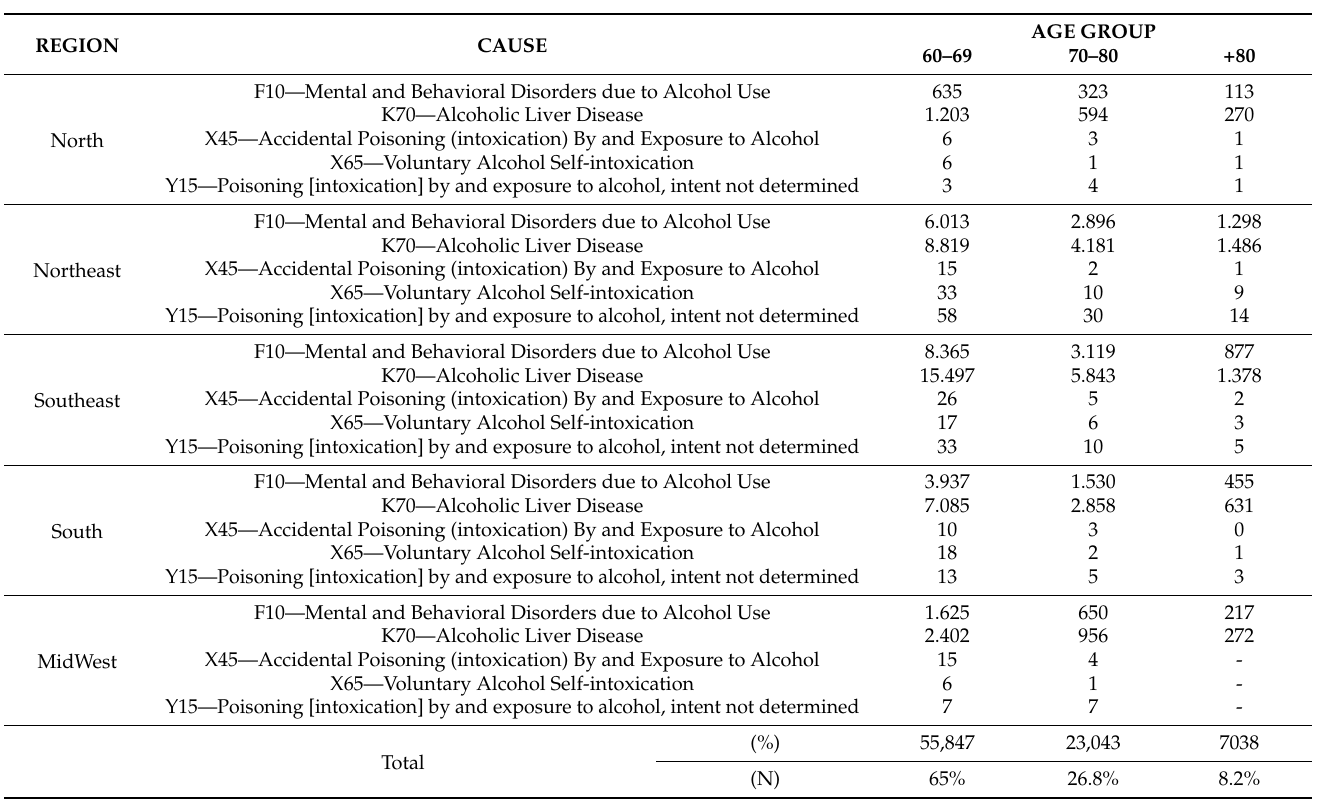
Table 2. Mortality by CID-10 category related to alcohol consumption in the elderly by Brazilian region from 1996 to 2019.